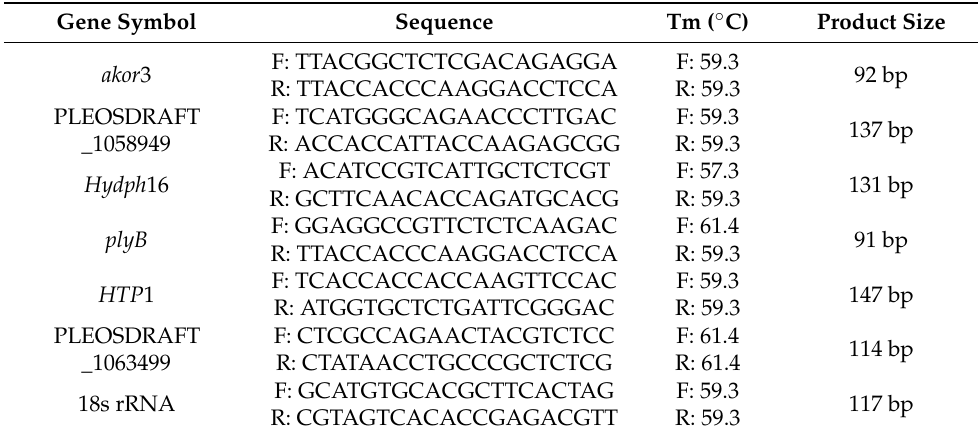
Table 1. List of qRT-PCR primers used in this study.